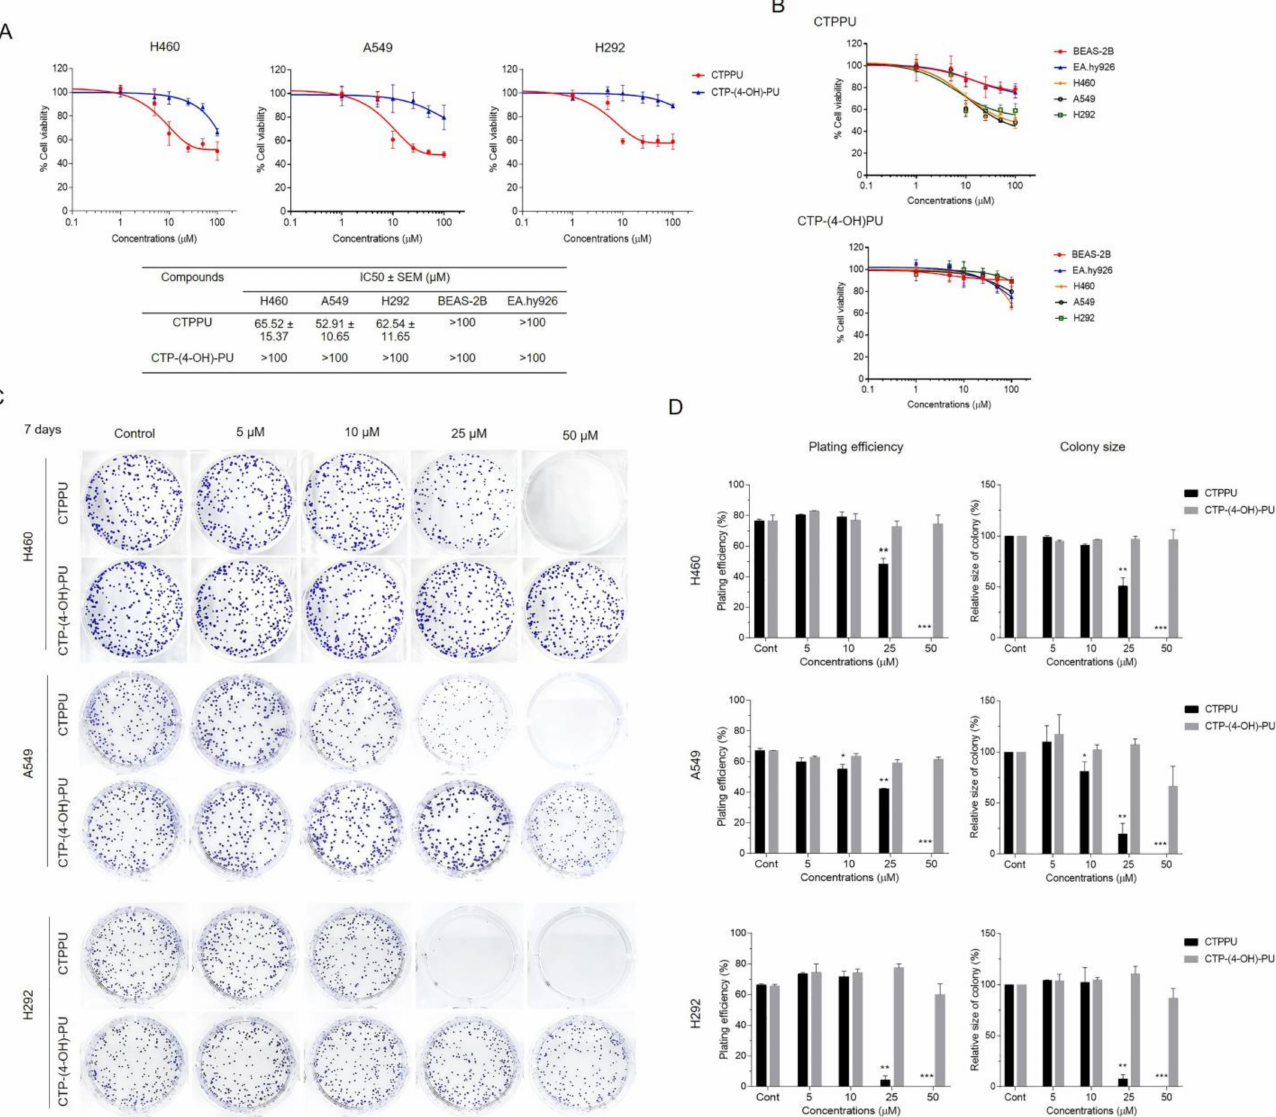
Figure 2. Effects of N,N (cid:48) -substituted phenylurea derivatives on NSCLC cell viability and prolifera- tion. ( A ) Cytotoxic effects of N,N (cid:48) -substituted phenylurea derivatives on NSCLC cell (H460, A549, and H292) and non-malignant cell (BEAS-2B and EA.hy926) line. Cells were treated with various concentrations (0–100 µ M) of CTPPU or CTP-(4-OH)-PU for 24 h. Viability was quantitated by MTT assay. ( B ) Compare the cytotoxicity of N,N (cid:48) -substituted phenylurea derivatives on cancer cells vs. normal cells. ( C ) Growth inhibition effects of CTPPU and CTP-(4-OH)-PU on NSCLC cell lines were measured by colony formation assay. ( D ) Bar graphs showed the quantitative results of C; the left part shows the plating efficiency, and the right part shows the colony size after the indicated treatment. Each value is the mean ± SD from triplicate samples. * p < 0.05, ** p < 0.01, and *** p < 0.001 compared with the